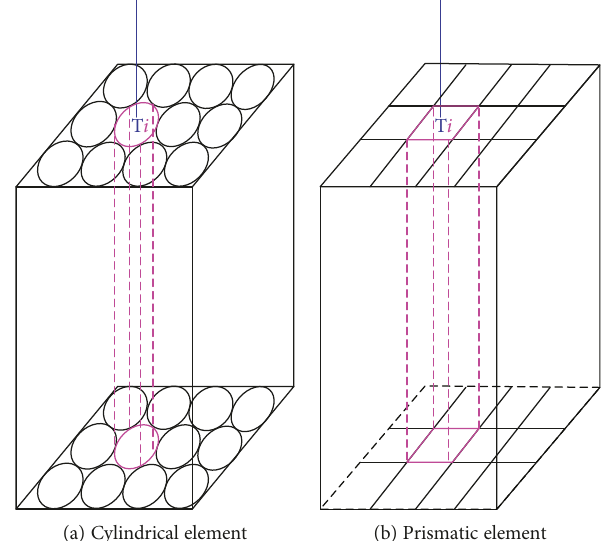
Figure 1: Schematic diagram of CESM .